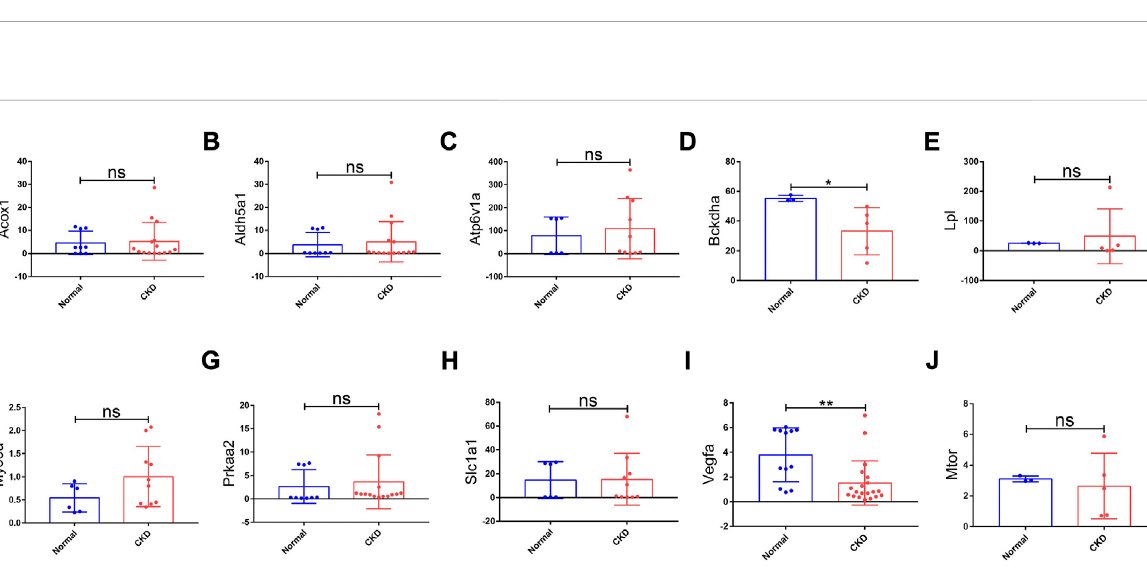
FIGURE 8 Expression levels of hub genes in CKD kidney tissues and normal kidney tissues based on the validation set of the GSE66494 dataset. (A) Acox1 ; (B) Aldh5a1 ; (C) Atp6v1a ; (D) Bckdha ; (E) Lpl ; (F) Myo5a ; (G) Prkaa2 ; (H) Slc1a1 ; (I) Vegfa ; and (J) Mtor . No results matched “ Pi4ka ” in the validation set of the GSE66494 dataset. CKD, chronic kidney disease; ns, no signi fi cance; * p < 0.05 and ** p <